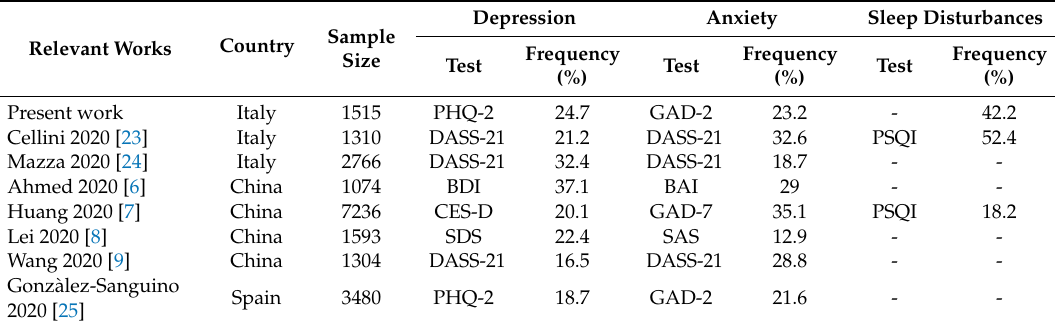
PHQ-2 Patient Health Questionnaire-2; GAD-2: Generalized Anxiety Disorder-2; DASS-21: Depression, Anxiety and Stress Scale-21; PSQI: Pittsburg Sleep Quality Index; BDI: Beck Depression Inventory; BAI: Beck Anxiety Inventory; CES-D: Center for Epidemiology Scale for Depression; GAD-7: Generalized Anxiety Disorder-7: SDS: self-rating depression scale; SAS: Self-rating anxiety